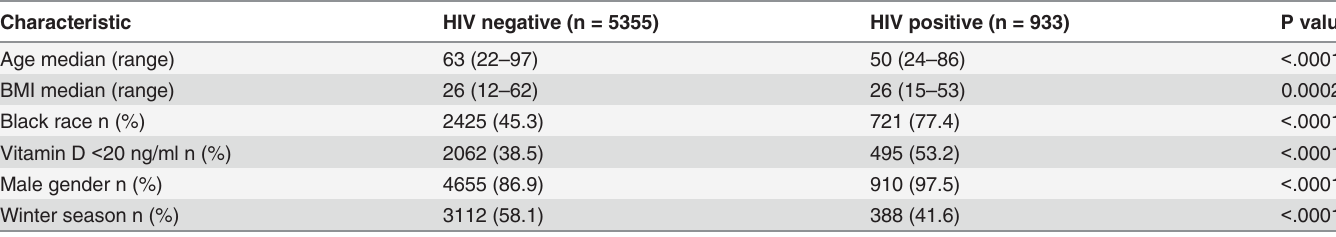
Table 2. Characteristics of HIV-negative versus HIV positive